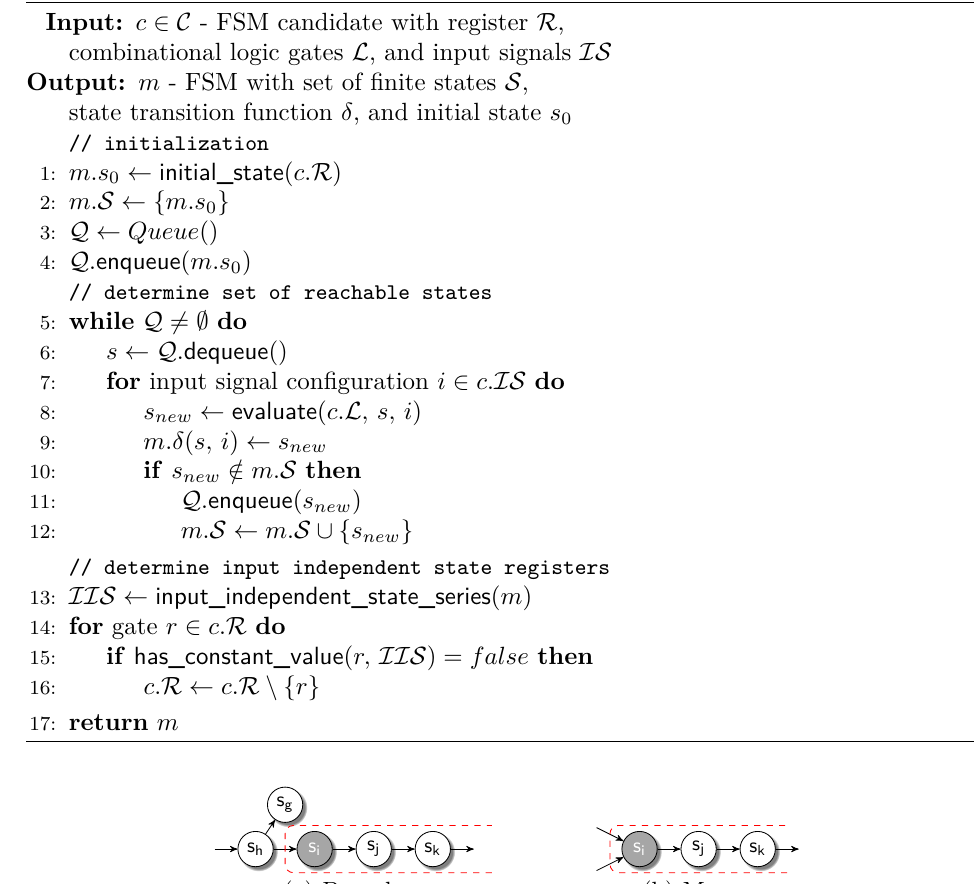
Algorithm 2 Boolean Function Analysis